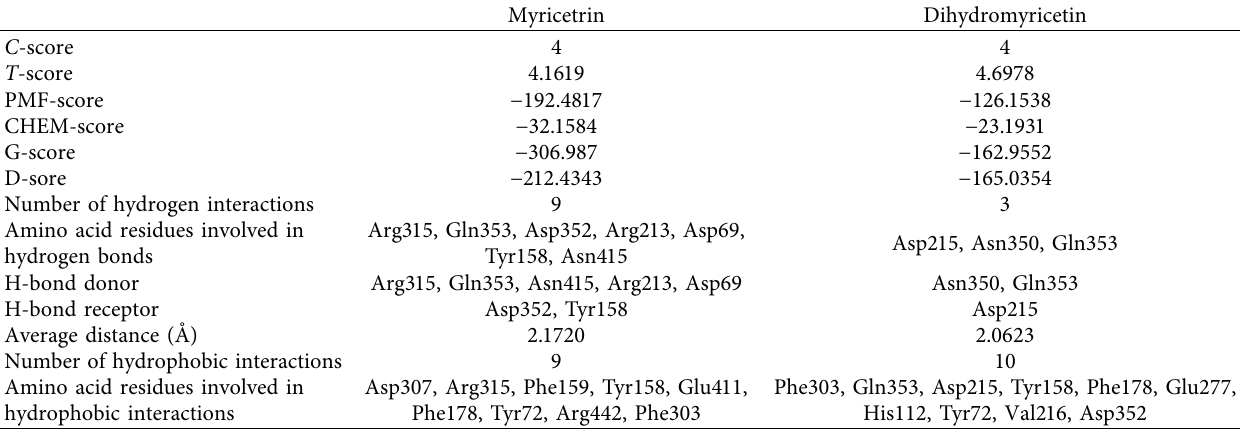
Table 3: Docking parameters, hydrogen bonds, and hydrophobic interactions observed between flavonoids and α -glucosidase from molecular docking simulation analysis.